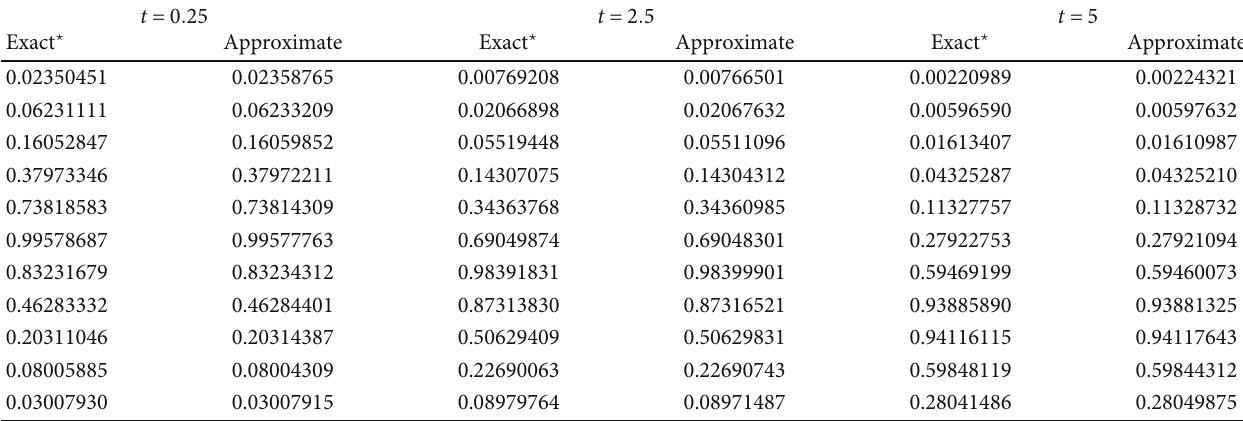
Table 3: Comparison of outcomes at α = 0 : 95 for di ff erent time levels.